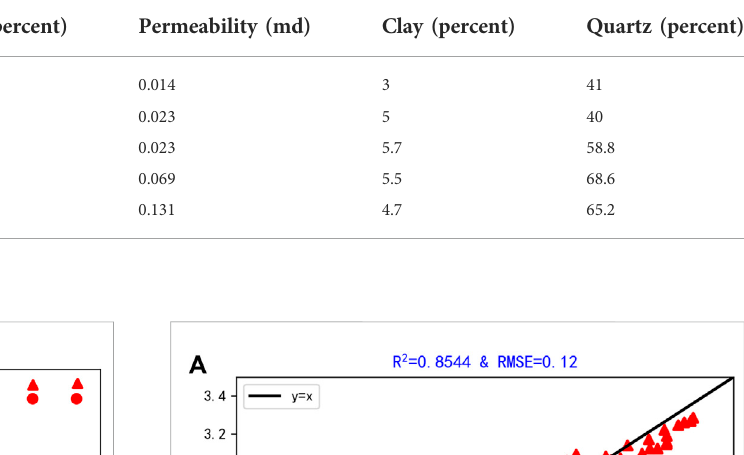
TABLE 3 petrophysical parameters of fi ve tight sandstone samples.